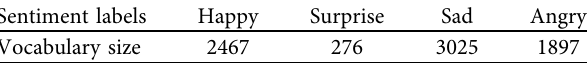
Table 3: Classification of sentiment